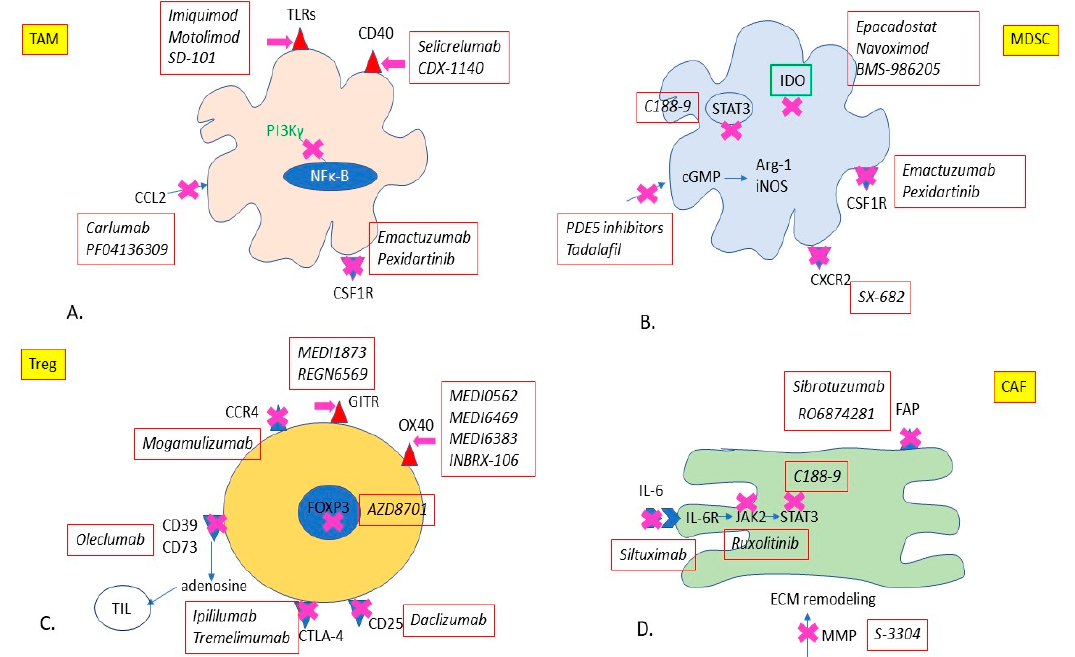
Figure 1. Therapeutic strategies for TME-directed therapy. ( A ) Targeting TAMs: (1) Anti-CCL2: Monoclonal antibody Carlumab, CCL2 antagonist PF04136309, (2) Anti-CSF1R: Monoclonal Antibody